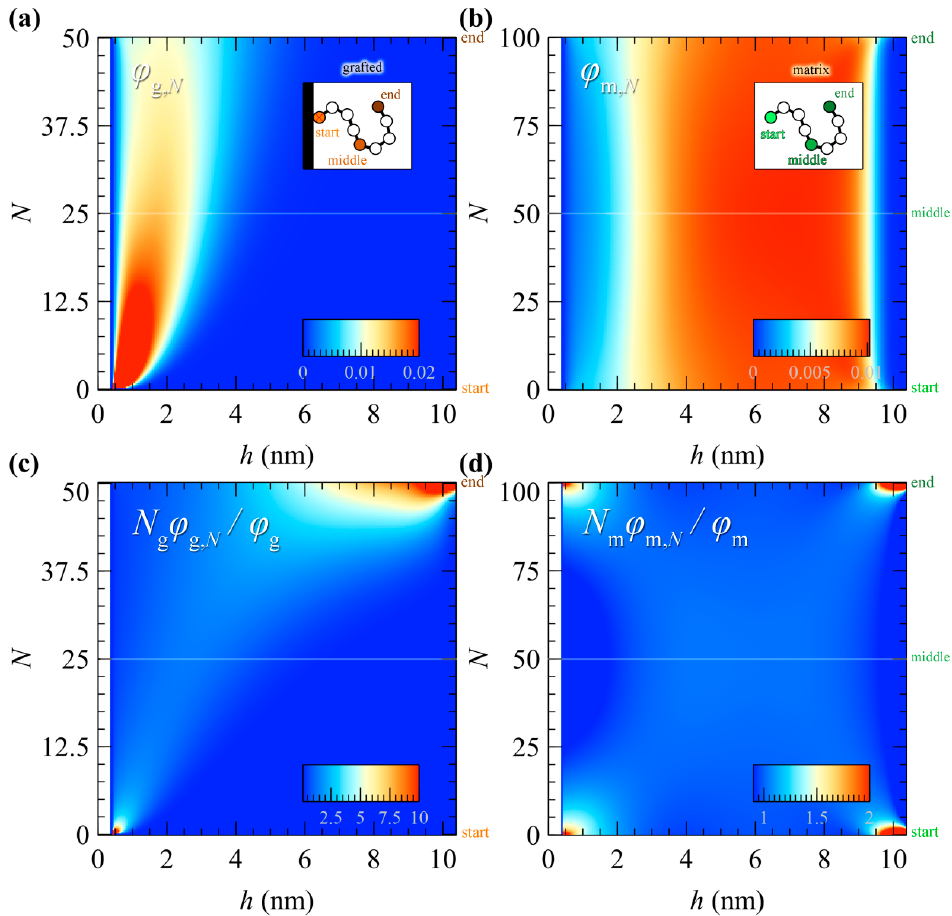
Figure 8. Contour plots of the reduced segmental density of ( a ) grafted and ( b ) matrix chains. The ordinate indicates the index of each segment along the contour and the abscissa is the distance of the segment from the left solid surface. Blue/red color corresponds to low/high values of the displayed quantity, as denoted by the color bars. The contour plots in ( c , d ) depict the corresponding normalized segmental density profiles defined in Equation (32). The profiles were obtained from a perfectly wetted SiO 2 /PS GMV system (see Table 1 in Ref. [27]) with σ g − = 0.4 nm –2 , N g − = 50, N m = 100, and L = 10 nm. The horizontal line is a guide to the eye that passes through the region corresponding to middle segments.